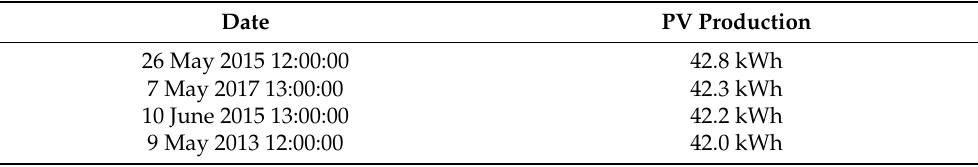
Table 1. Intervals with the highest PV